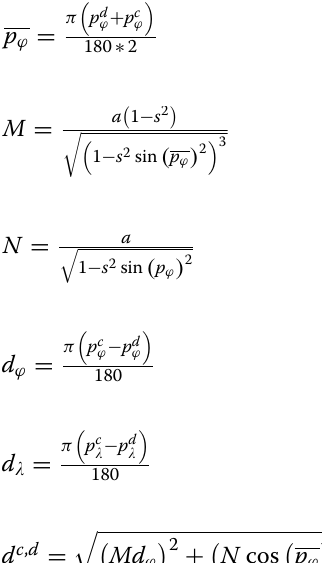
where a denotes the major axis and s denotes eccentricity of the earth model. d with superscript c, d denotes the distance between 2 different geodetic coordinates. A com- monly used earth model is WGS84, which has major axis value 6378137, and eccentric- ity value 0.0818191908426215 [18].